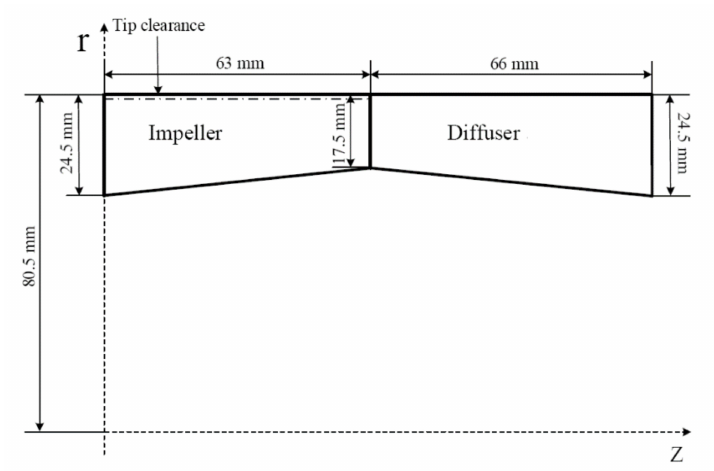
Figure 5. Meridian parameters of the impeller and diffuser.